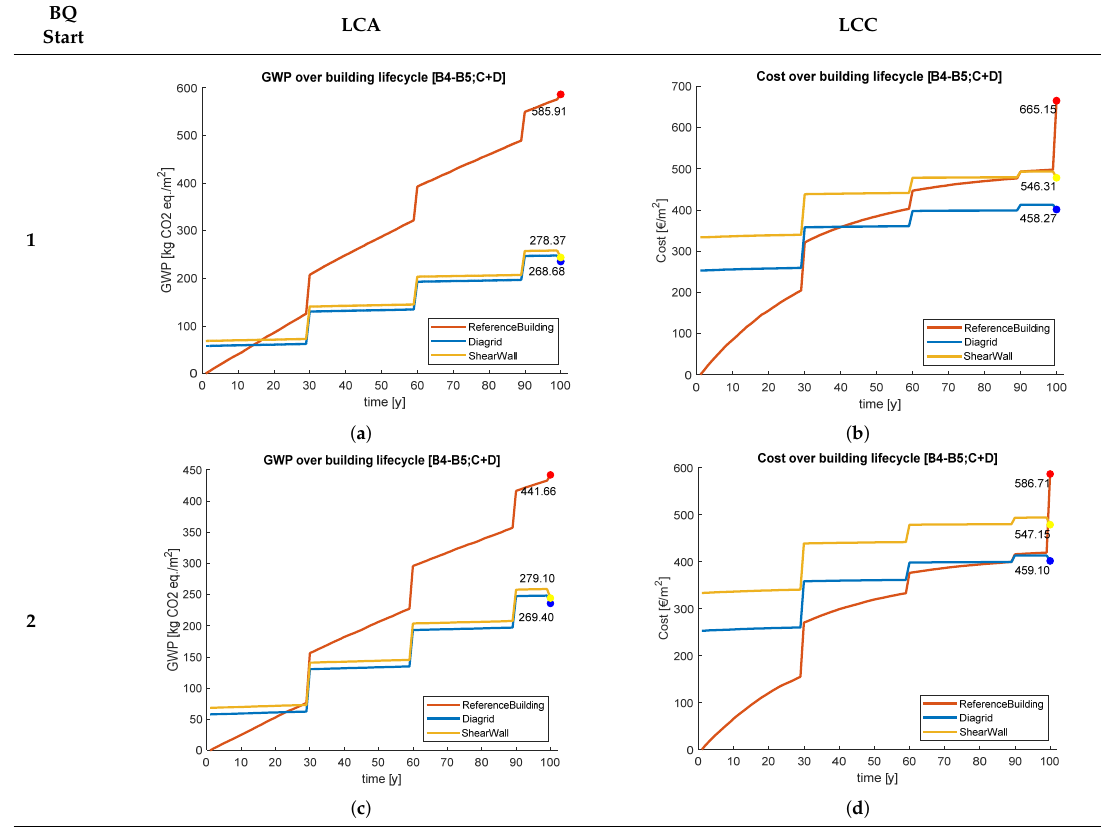
Table A1. Probabilistic LCA–LCC results without BQ variation due to earthquake occurrence.